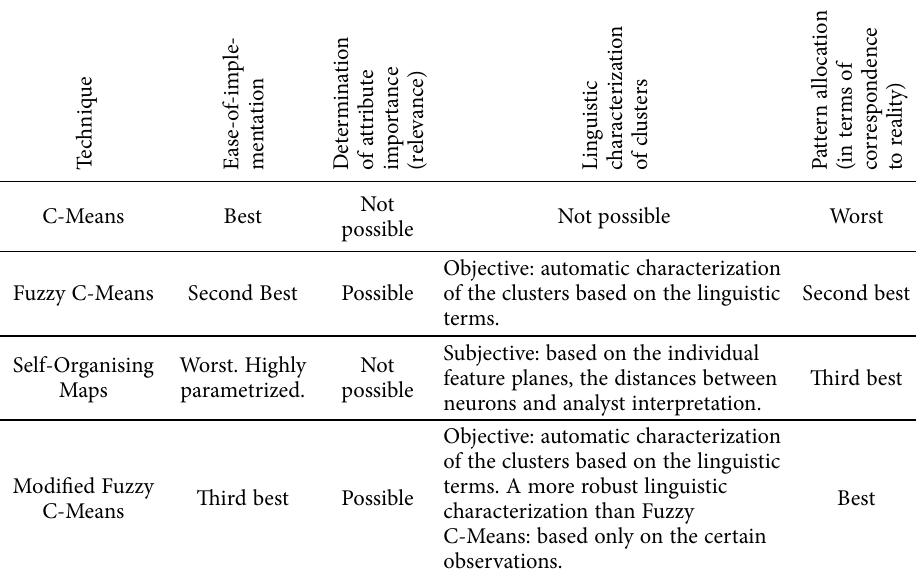
Table 4. The comparison of different clustering techniques for assessing NFIs’ financial performance